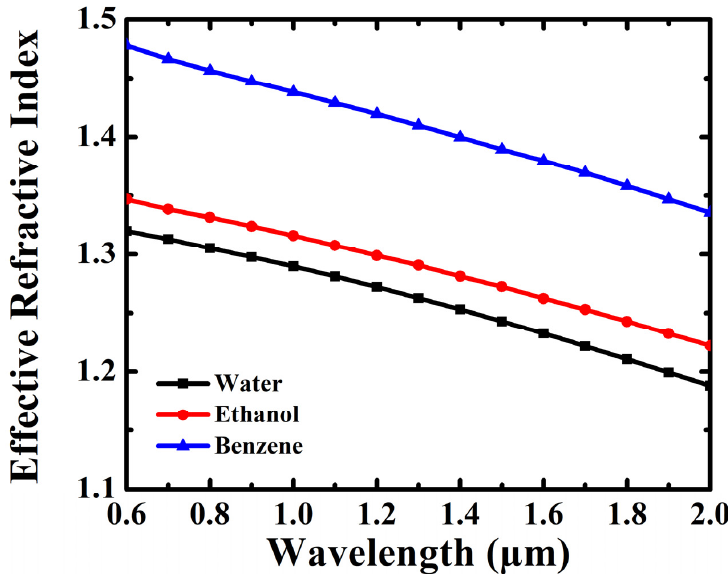
Figure 4. Effective refractive index of the proposed PCF with liquid analytes: water, ethanol and benzene.